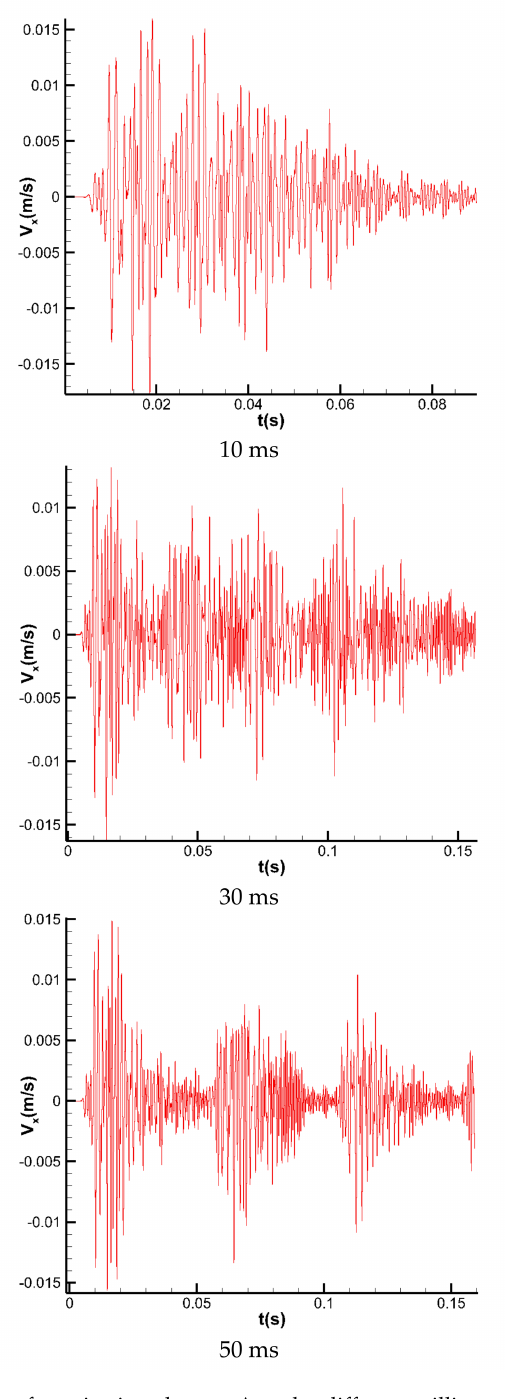
Figure 8. The blasting vibration velocity of monitoring element A under different millisecond